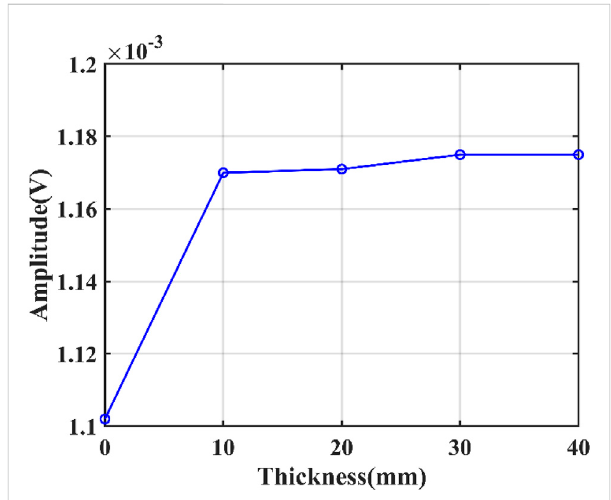
FIGURE 8 z-directional displacement of the receiving point in intact cementation.